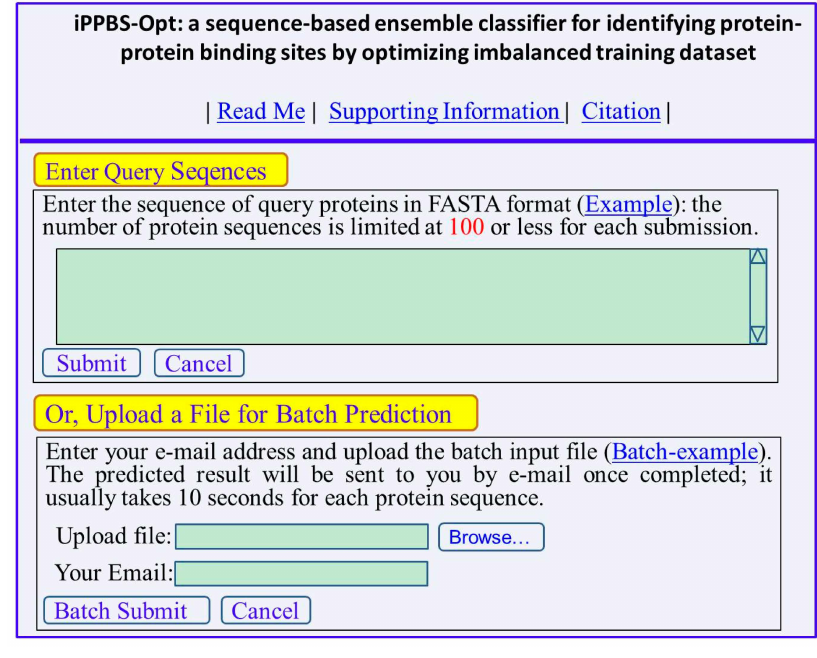
Figure 6. Asemi-screenshotofthetoppageforthewebserver iPPBS-Opt athttp://www.jci-bioinfo.cn/iPPBS-Opt. Step 2 . Either type or copy/paste the query protein sequences into the input box at the center of Figure 6. The input sequence should be in the FASTA format. For the examples of sequences in FASTA format, click the Example button right above the input